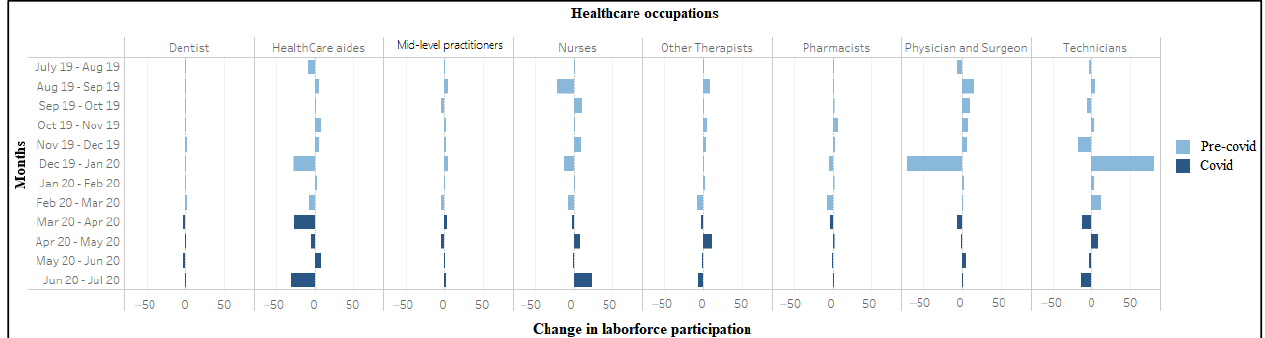
Figure 6. Change in labor force participation (in ten thousand) among workers in healthcare occupations (July 2019–2020).